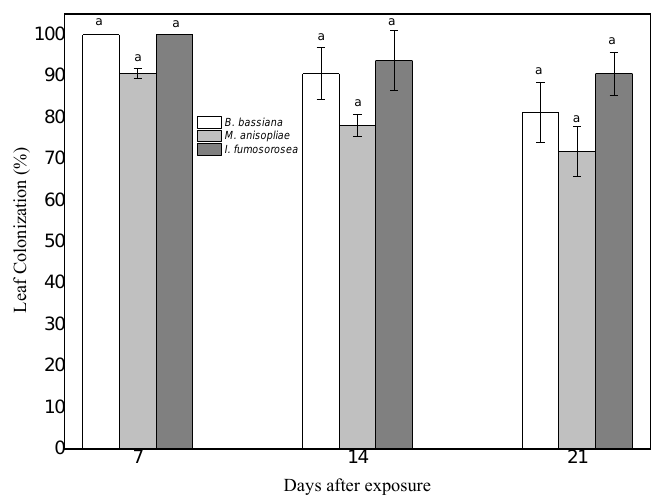
Figure 1. Mean (±sd; n = 24) surface colonization of same age C. annum leaf parts by B. bassiana , M. anisopliae and I. fumosorosea at 7 days, 14 days, and 21 days after exposure. Mean ± sd values with the same superscript letter are not different in a significant way (Bonferroni’s test: p < 0.05).